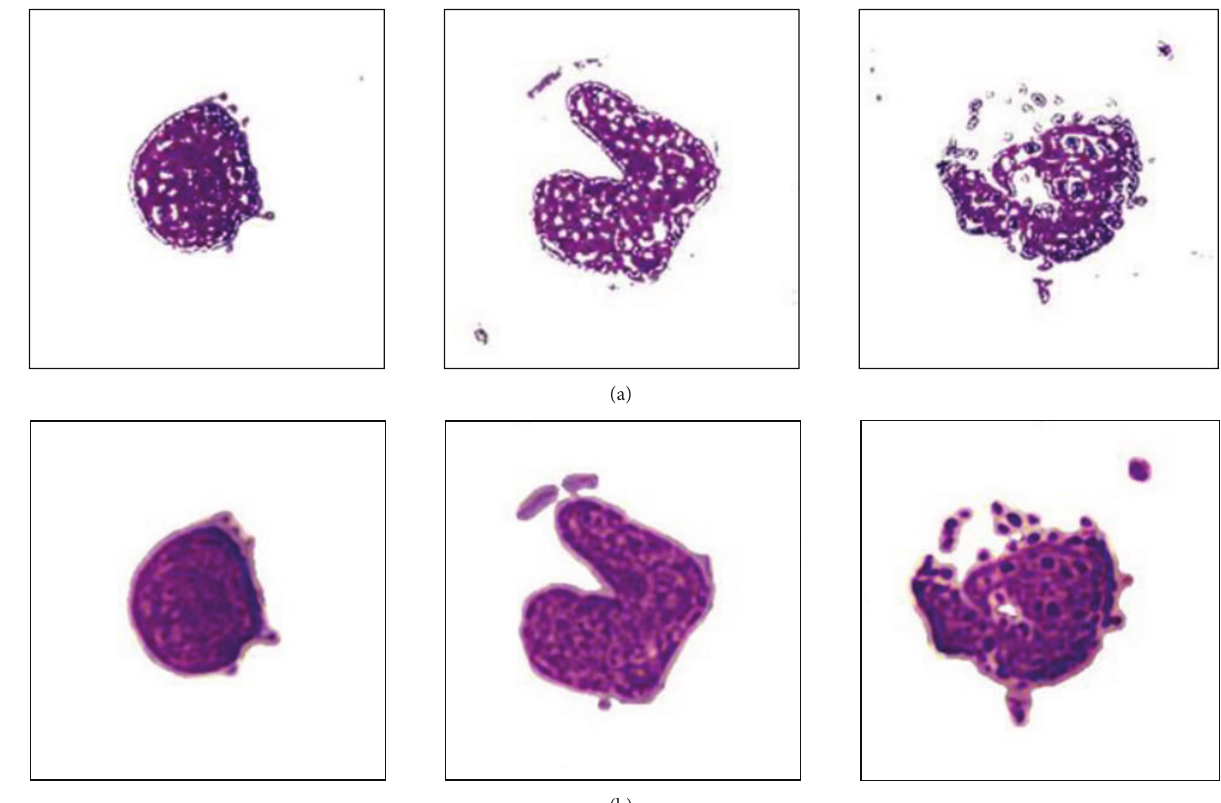
Figure 2: The detected white blood cell. (a) The detected cell based on the result of (1). (b) The detected cell after the morphological operators.